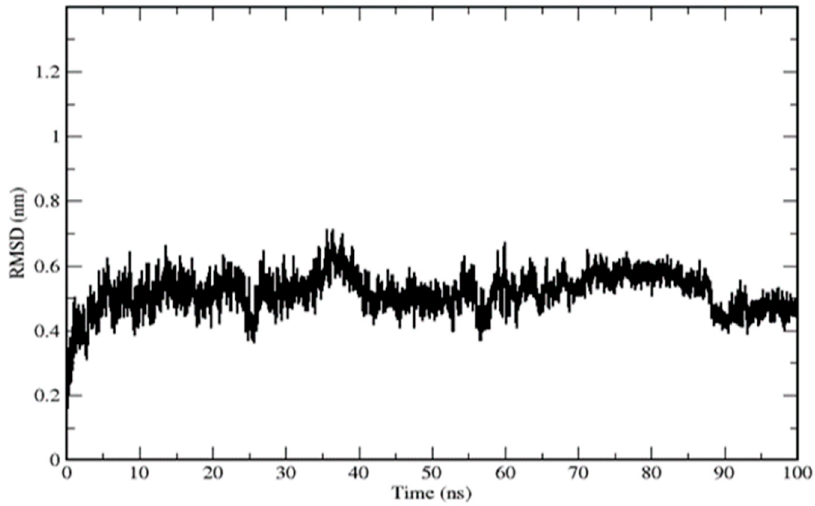
Figure 2. Root-mean-square deviations of the MSTN–DTQ complex. The RMSF diagram showed fluctuations at N and C terminals of MSTN. Backbone